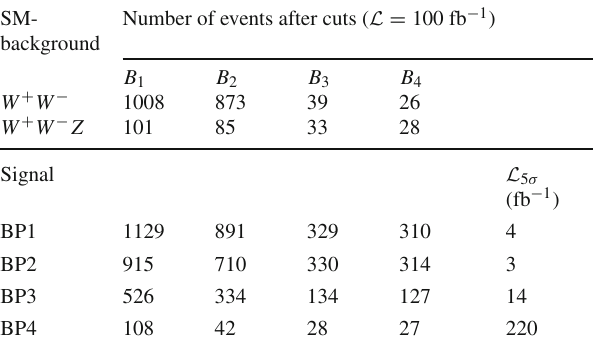
Table 10 The cut-flow for signal and backgrounds along with the sig- nificances for BP1, BP2, BP3 and BP4 at 1 TeV ILC and the